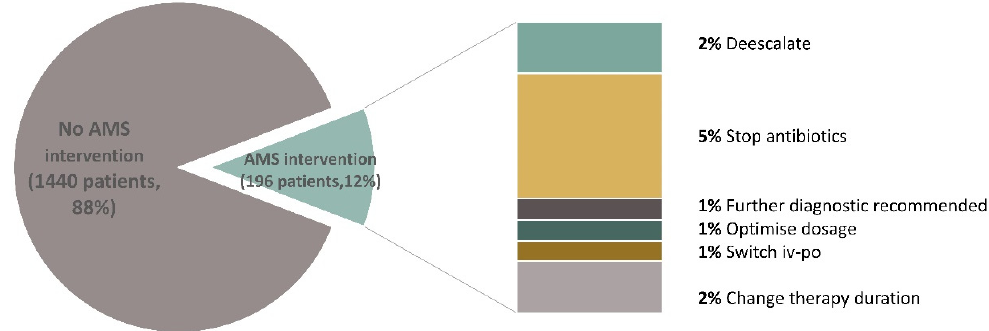
Figure 1. Antimicrobial stewardship interventions. AMS: antimicrobial stewardship.